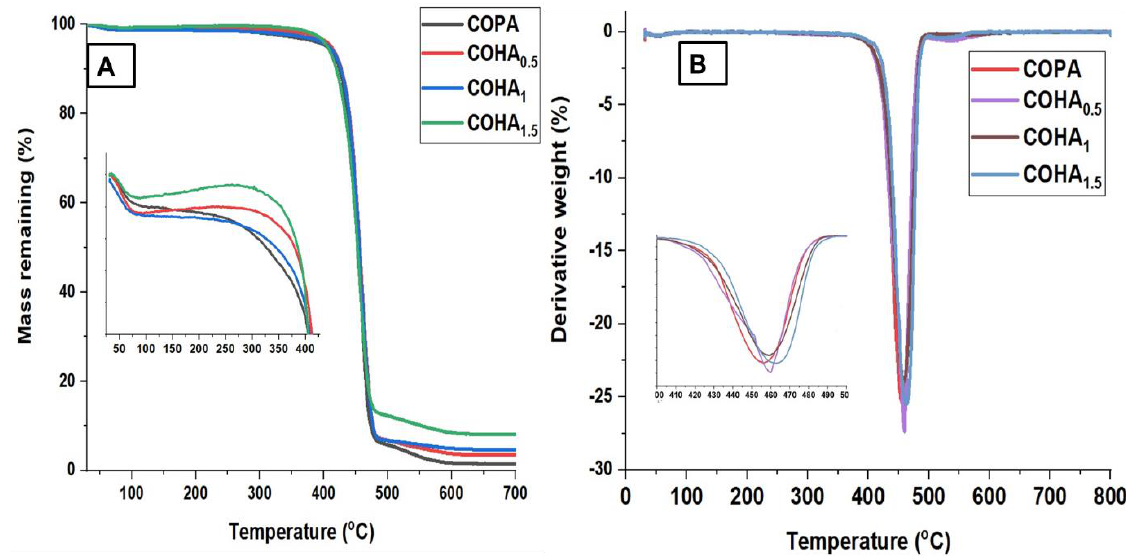
Figure 5. ( A ) TGA and ( B ) DTA curves of neat copolymer and COHA polymer nanocomposites.